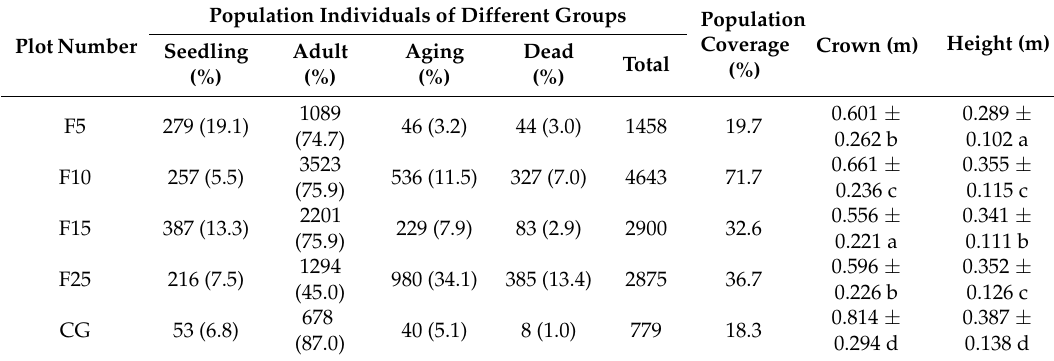
Table 2. Category and basic parameters of A. ordosica population in five plots, F5 (enclosed 5